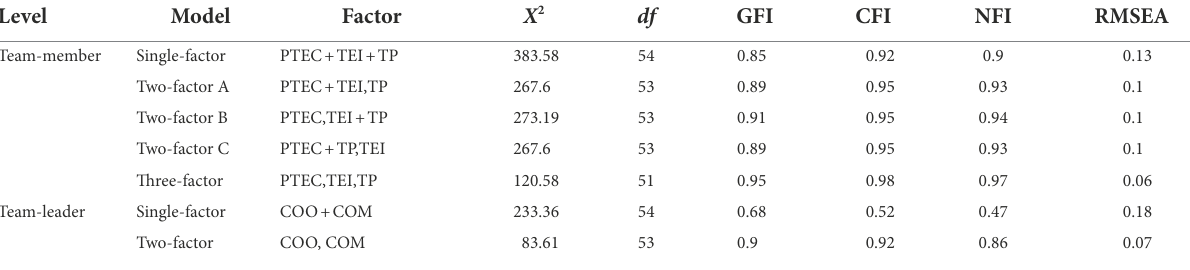
TABLE 2 Structural validity test of different source scales.